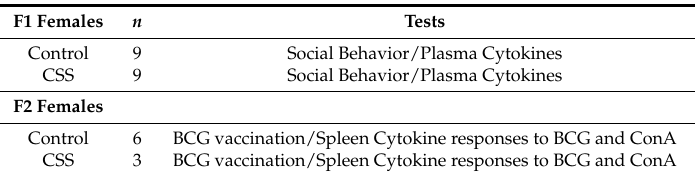
Table 1. Summary of experimental procedures.